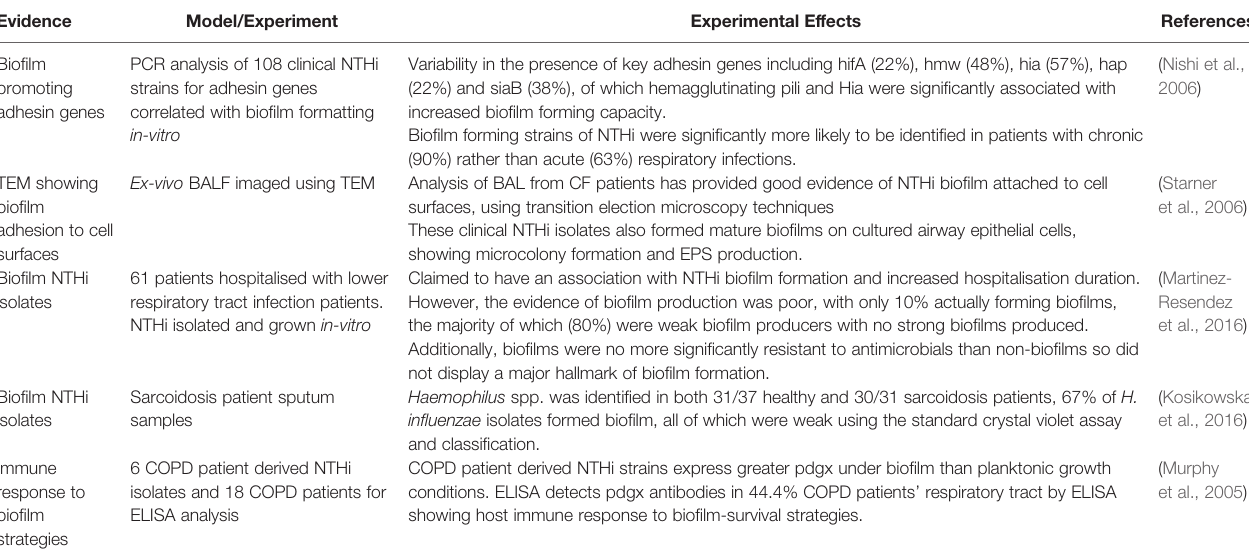
TABLE 4 | Summary of Clinical Evidence for NTHi Bio fi lms ( ex-vivo